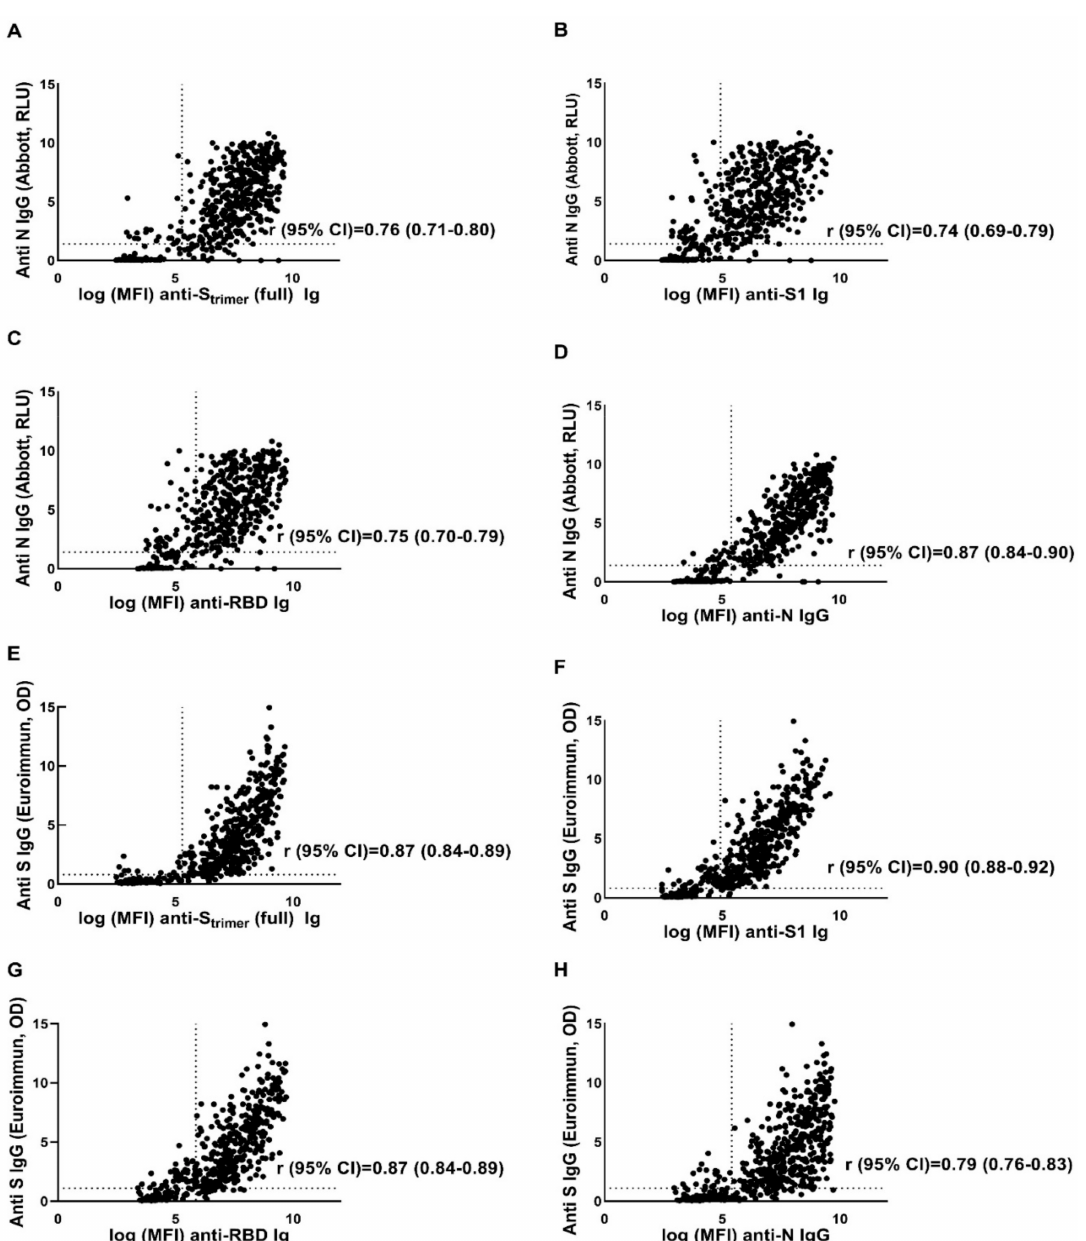
Figure 1. Spearman‘s correlation coefficient (r) and 95% CI between four antigenic targets of SARS-CoV-2 plotted against the Abbott anti-N IgG antibodies ( A – D ) and Euroimmun anti-S1 IgG antibodies ( E – H ). Dotted horizontal lines represent the cutoff values for the chemiluminescent microparticle immunoassay (CMIA)-based assay ( A – D ) and ELISA-based assay ( E – H ). Dotted vertical lines indicate cutoff values for the four antigenic targets of MBIA-based assay as calculated by the low positive control. MFI = mean fluorescence intensity, RLU = relative light unit, OD = optical density, S trimer = spike protein trimer, S1 = S1 subunit of the spike protein, RBD = receptor binding domain of the spike protein, N =